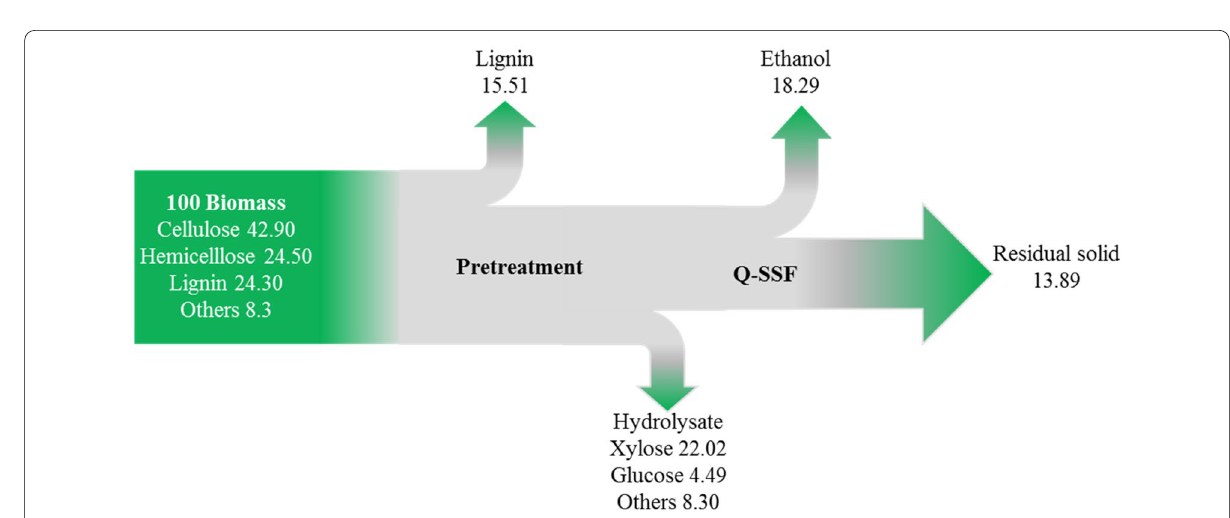
Fig. 9 Mass balance of biomass via hydrotrope pretreatment and